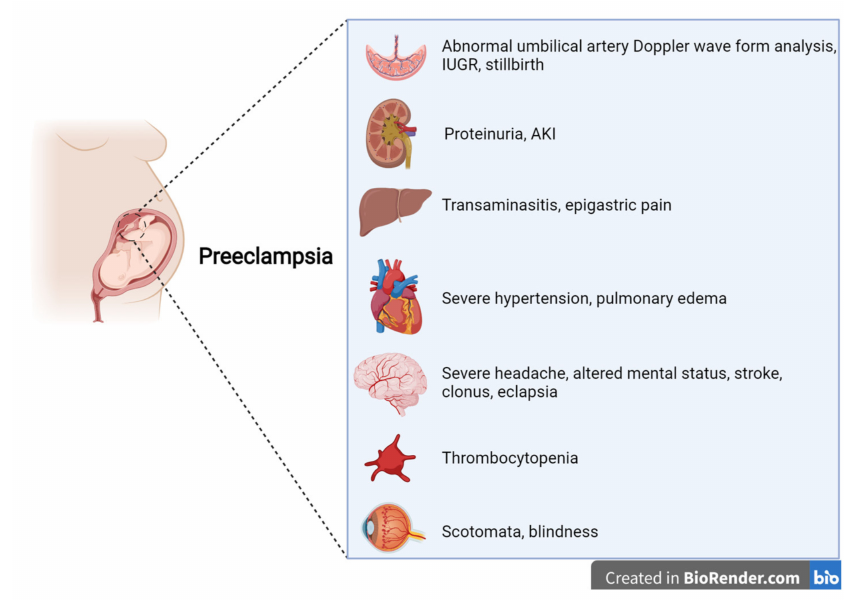
Figure 1. Features of preeclampsia, according to international